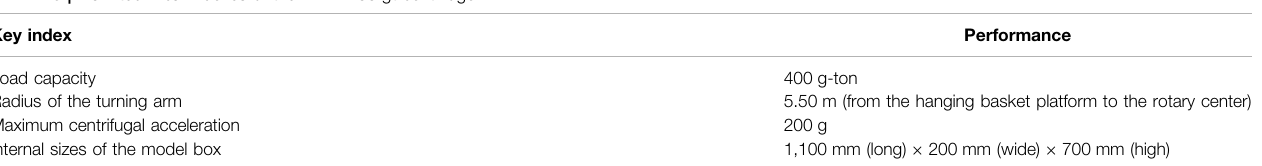
TABLE 3 | Main technical indexes of the NHRI-400 gt centrifuge.